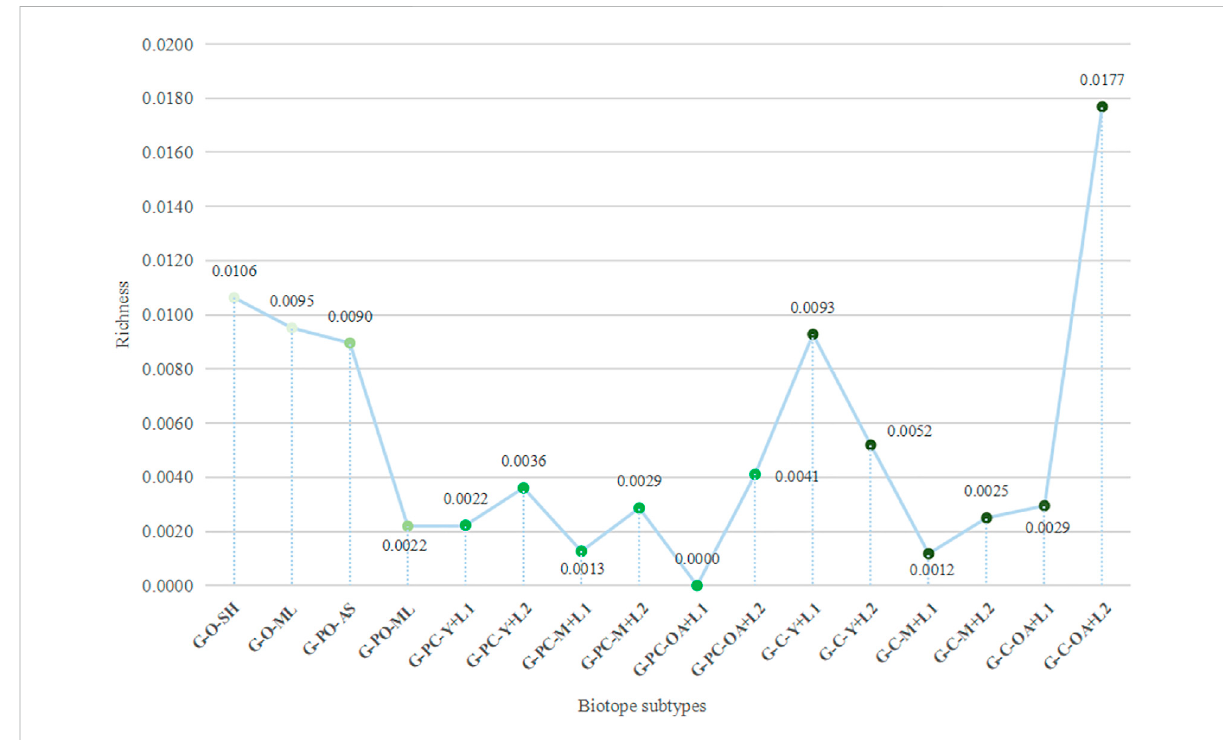
FIGURE 7 Spontaneous vegetation richness in biotope subtypes.